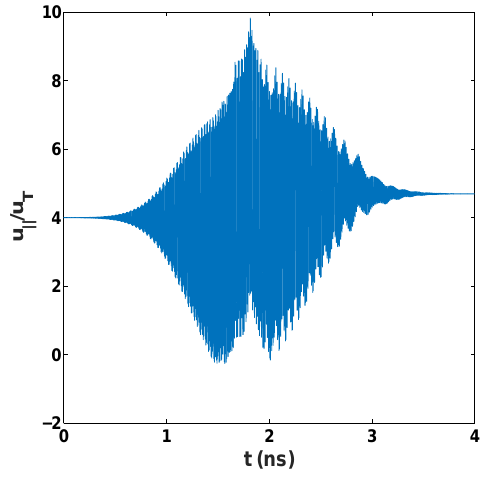
Figure 3. The parameters are the same as in Fig. 1 except that the beam power is 10 MW.